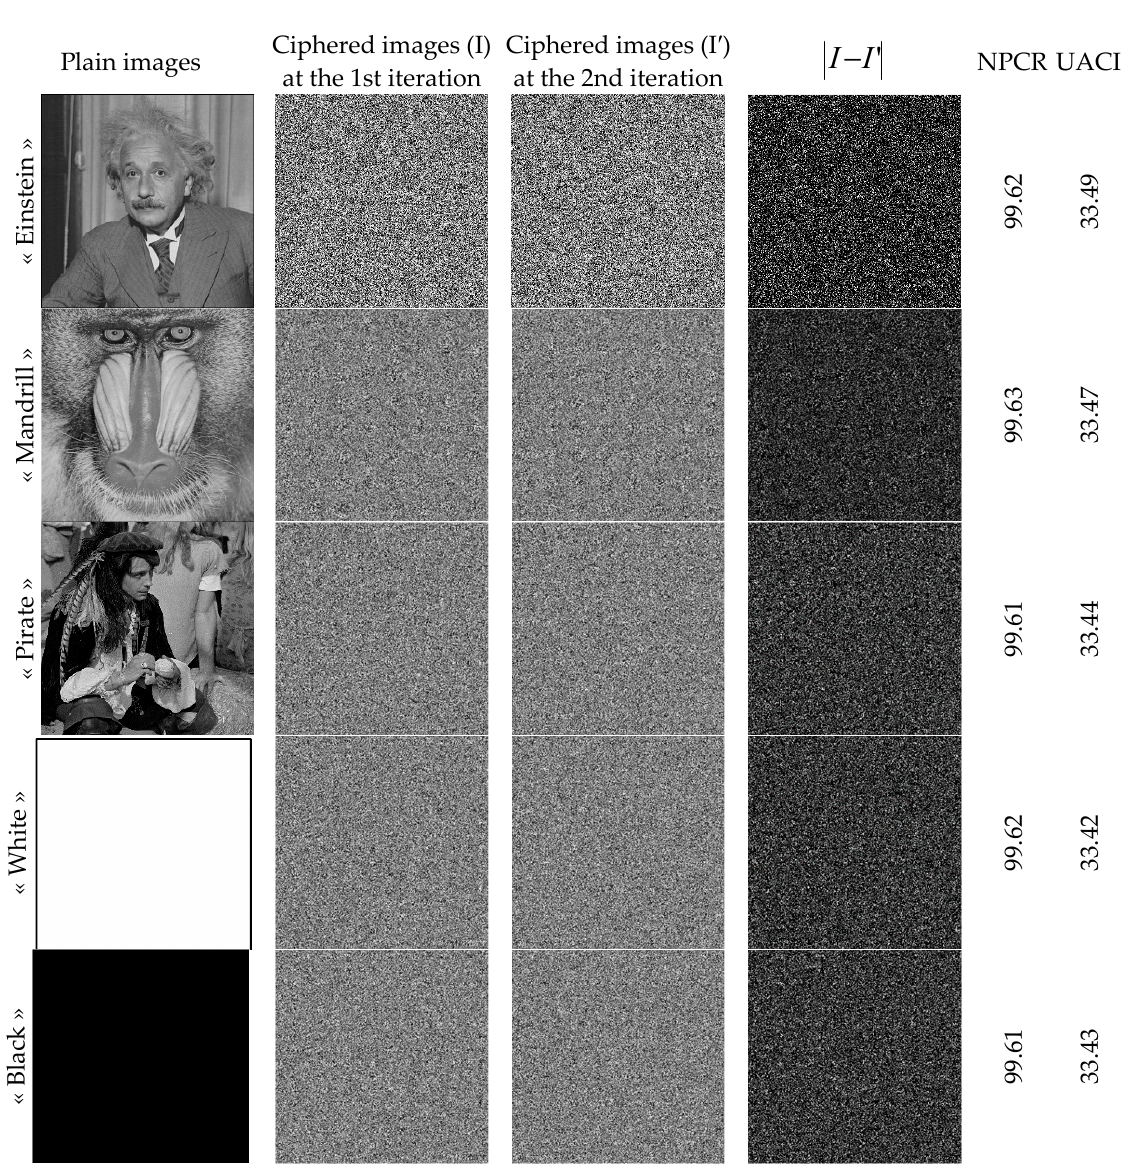
Figure 18. Plain {“Einstein,” “Mandrill,” “Pirate,” “White,” “Black”} images with their encrypted versions at two consecutive iterations of the proposed scheme with the corresponding NPCR and UACI values.